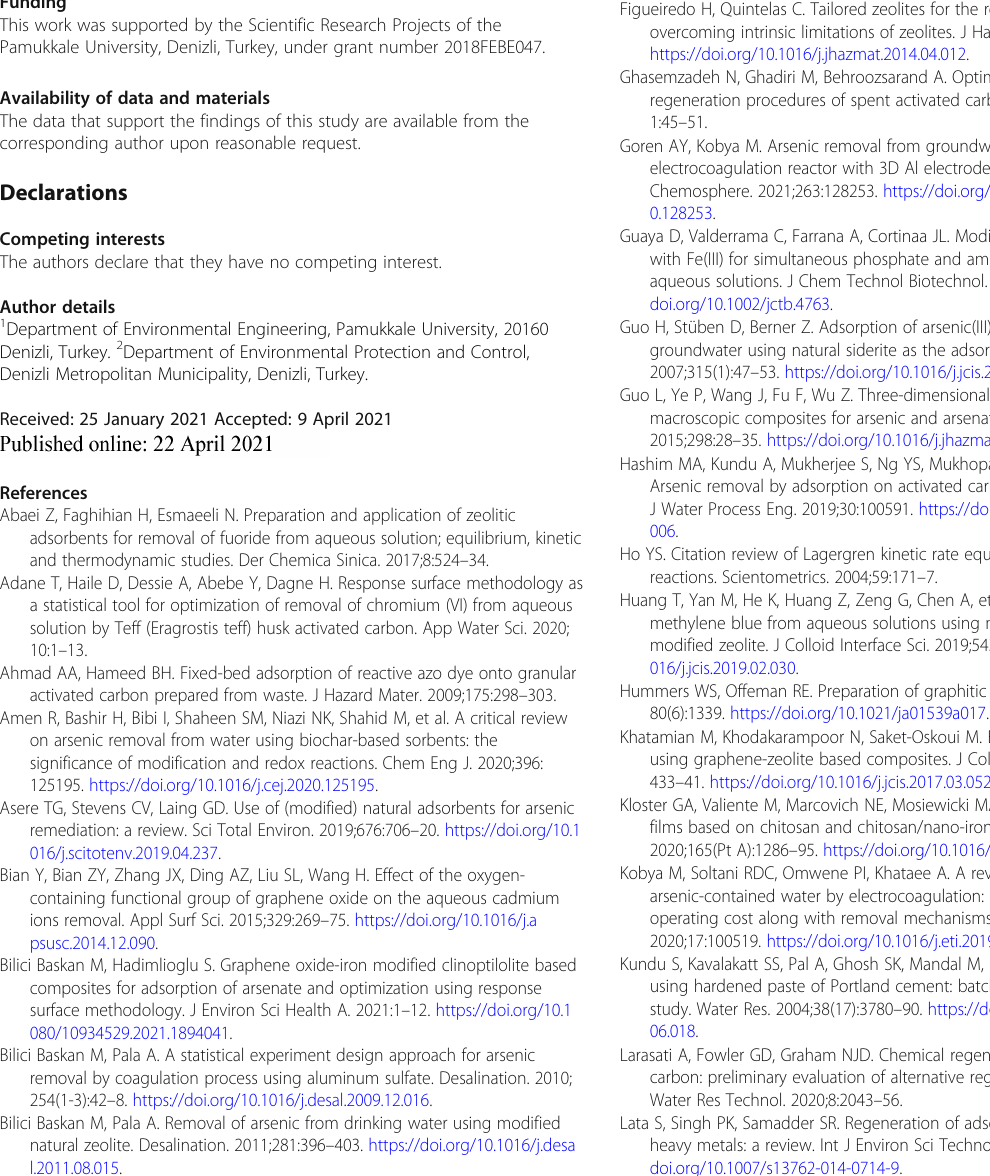
Figueiredo H, Quintelas C. Tailored zeolites for the removal of metal oxyanions: overcoming intrinsic limitations of zeolites. J Hazard Mater. 2014;274:287 –